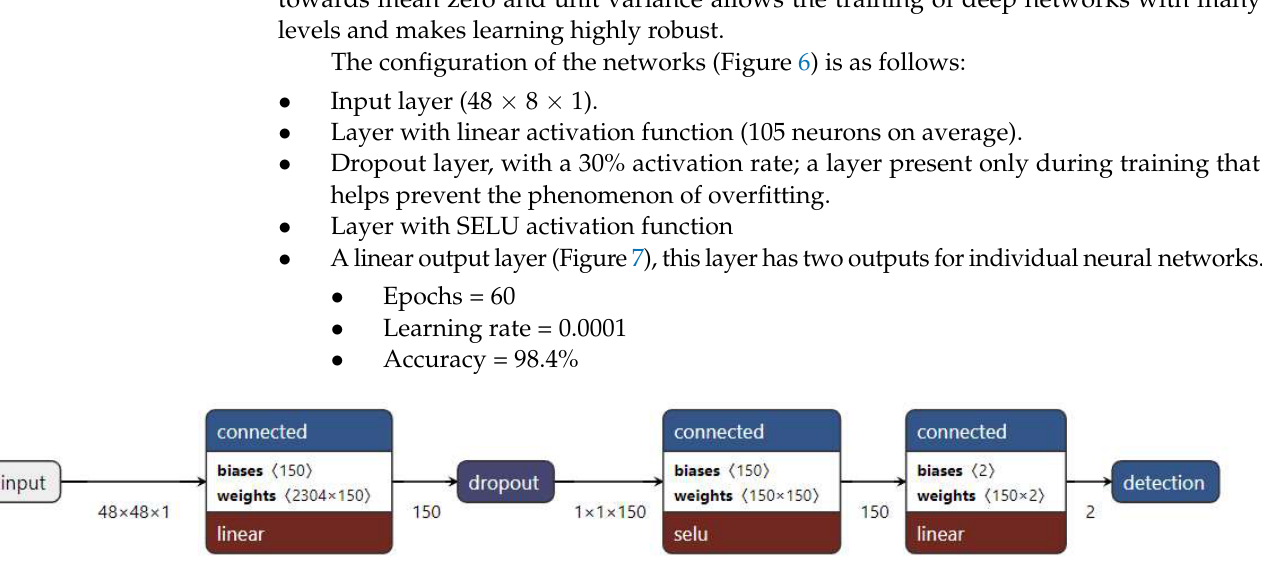
Figure 7. Attributes of output layer.